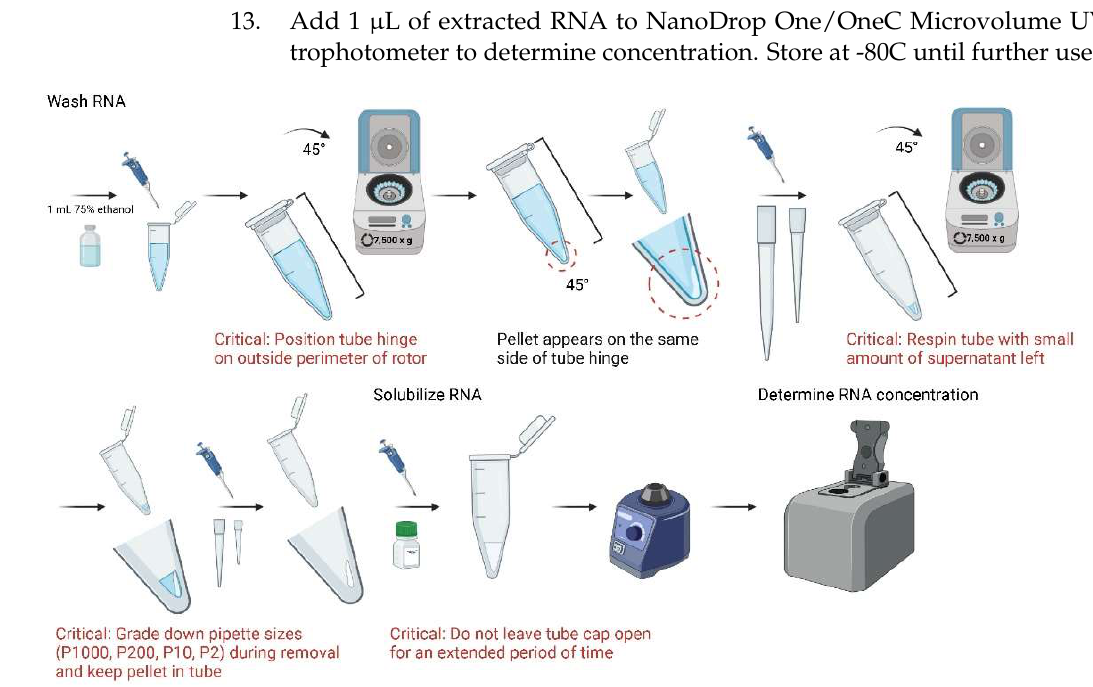
Figure 7. Schematic workflow of final key steps in the isolation of RNA from microglia and